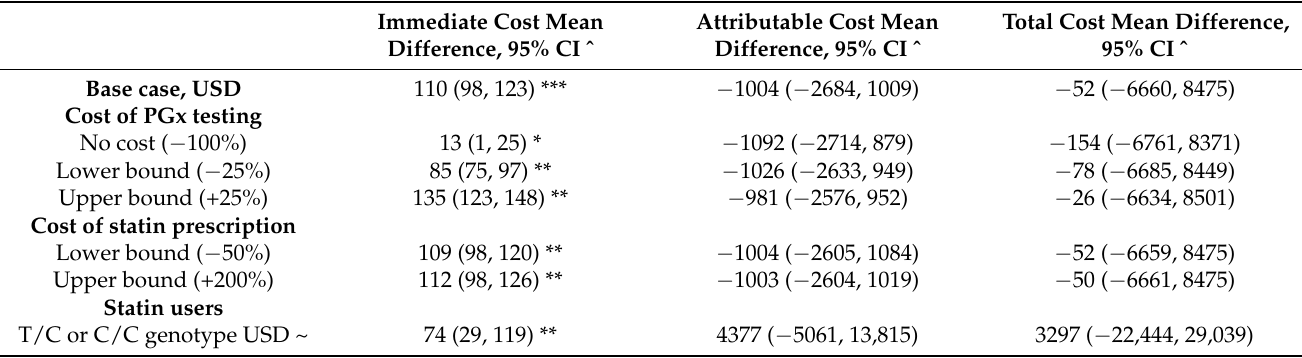
Table 4. Scenario and sensitivity analyses: cost of PGx testing, cost of statin prescriptions, and statin initiations among C variant carriers over the 12-month trial